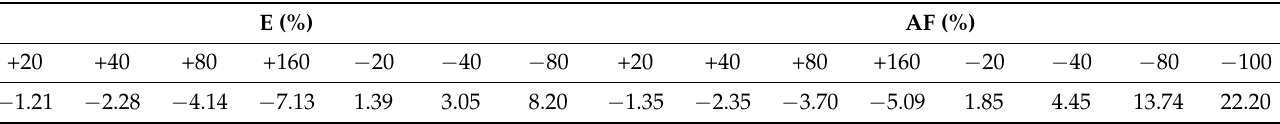
Figure 11. Change rates of G (%) due to changes in E or AF (%), with AF or E retaining their original values. Table 7. Change rate of G (%) due to changes in E or AF (%), with AF or E retaining their original values. The change rate of G was computed using (G caln − G cal ) × 100/G cal , where G caln is G cal using new E or AF, and G cal is the previous estimation using the original values of E and